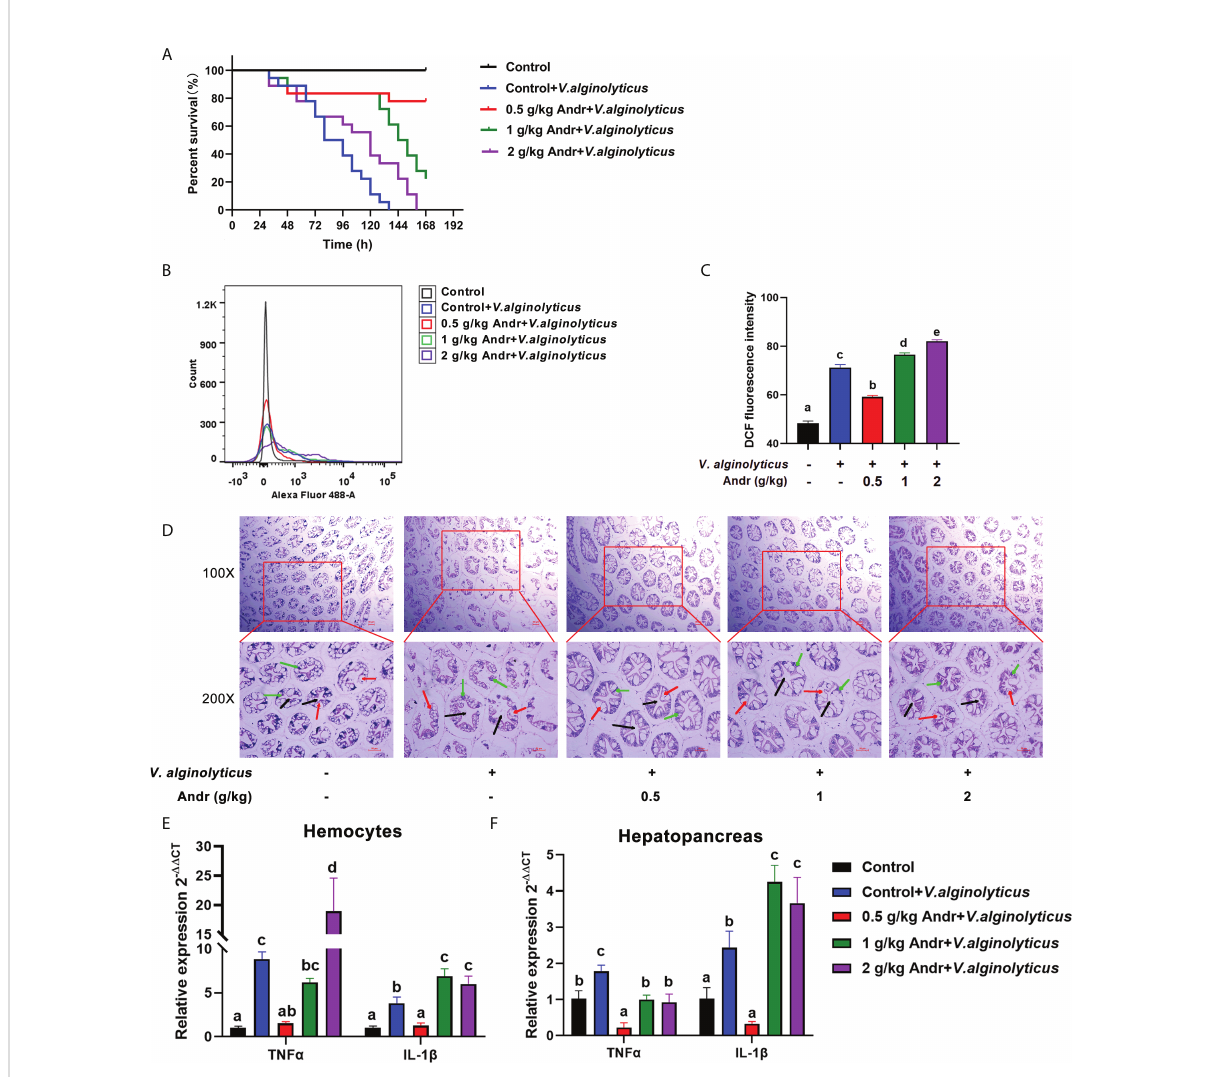
FIGURE 5 Andr alleviates oxidative damage and in fl ammatory response induced by V. alginolyticus infection on L. vannamei . (A) Percent survival of L. vannamei fed diet with Andr challenged with V. alginolyticus . (B, C) The ROS level in hemocytes was evaluated by analyzing DCF fl uorescence intensity by fl ow cytometry. (D) Histopathological examination of the L. vannamei hepatopancreas under V. alginolyticus infection 6 h. Black arrows represent lumen of hepatic tubule of hepatopancreas, green arrows represent secretory cells of hepatopancreas, and red arrows represent absorptive cells of hepatopancreas. Scale bar, 50 mm. (E, F) The expression of TNF a and IL-1 b detected by qPCR. Values are means ± SD. a,b,c,d,e Value bars not sharing the same superscript letter are signi fi cantly different as evaluated by Duncan ‘ s test ( p <